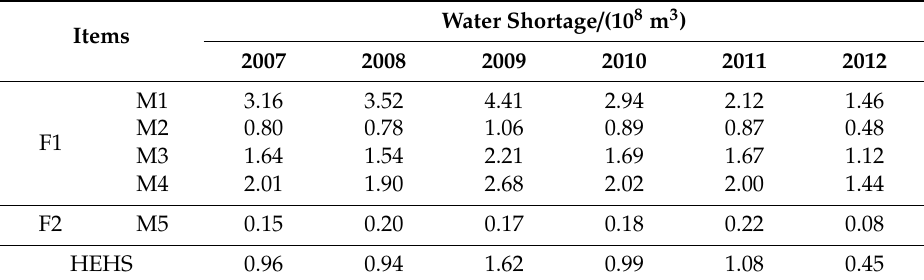
Table 2. Water shortage of restoration of healthy eco-hydrological sequence of rivers.